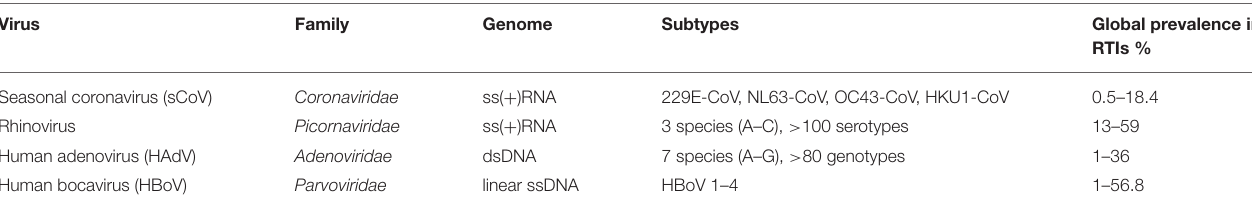
TABLE 1 | Taxonomy and global prevalence of four viral groups (seasonal coronaviruses, rhinoviruses, adenoviruses and bocaviruses) in individuals with respiratory tract infections (RTIs).